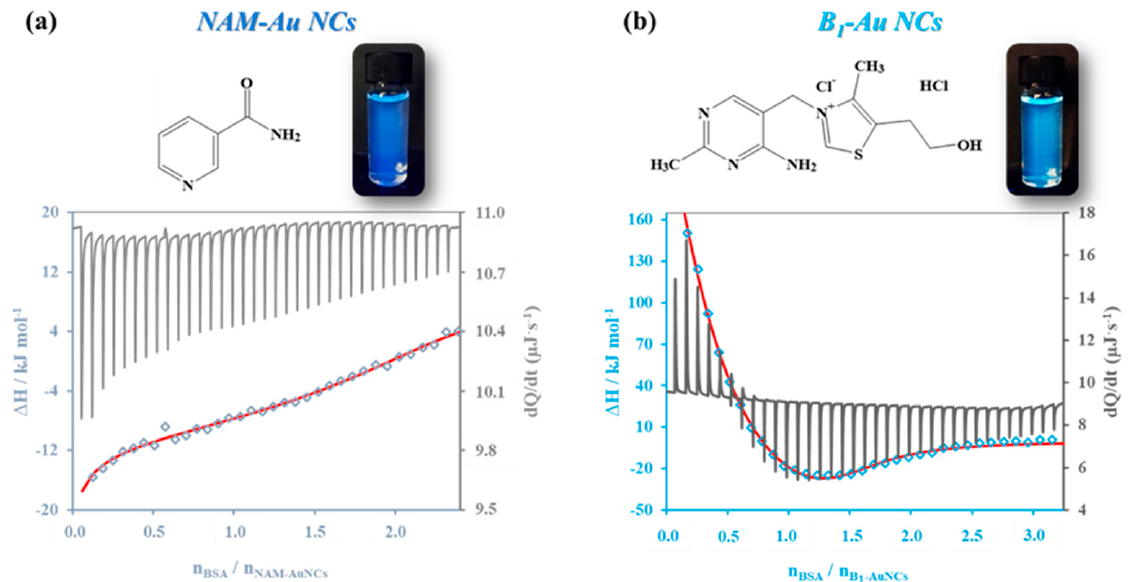
Figure 5. The calorimetric enthalpograms of the interaction between BSA and ( a ) NAM-Au NCs or ( b ) B 1 -Au NCs’ fitting by two-site binding model with the structural formula of the stabilizing ligands and the photos of the NC samples under UV lamp ( λ max = 365 nm).